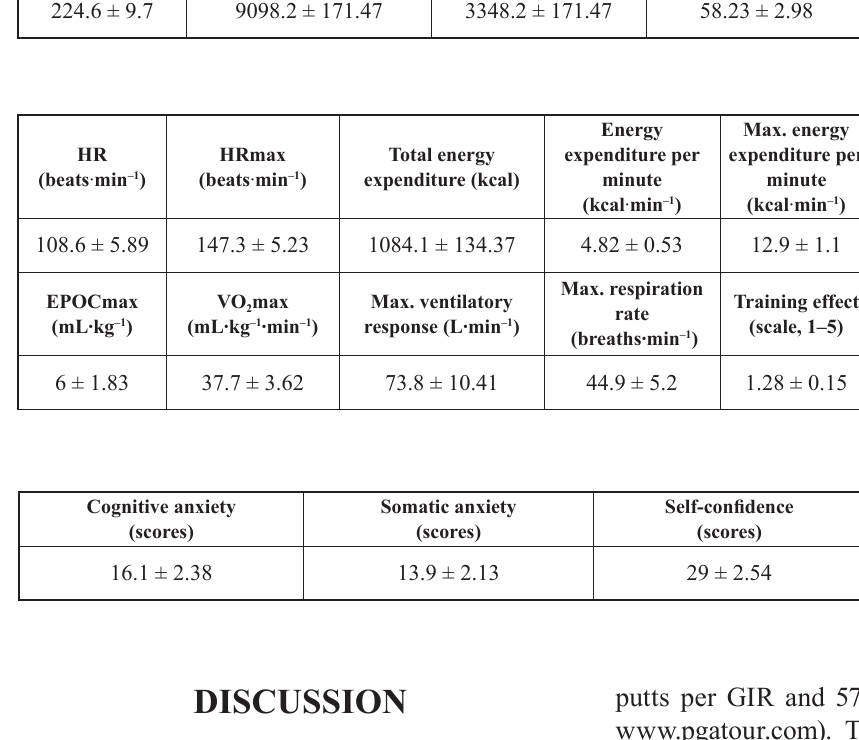
Table 3. Locomotion Demands of Youth Golfers